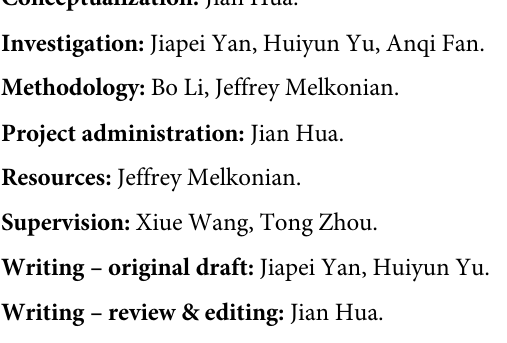
DC 3000 infection. Total RNAs were isolated from enriched guard cell preps and whole rosette leaves of 5-week-old plants. The expression was normalized to the expression of a reference gene ACTIN2 and relative to their expression in Col-0 Values are arithmetic means ± S.E., dif- ferent letters indicate statistically significant differences between indicated plant lines ( p < 0.05, based on one-way ANOVA followed by Student’s t test). S7 Fig. Stomatal responses to avirulent strains of Pst DC3000. Stomatal apertures in response to buffer alone (mock) and Pst DC3000 strains (with or without indicated effectors) in the Col-0 ( a, left panel of b ) and rpm1 ( right panel of b ). Results are from one set of experi- ment, error bars indicate SDs (n = 30 stomata). Asterisks indicate statistically significant differ- ences in stomata aperture between Pst DC3000 and avirulent Pst DC3000 treatment ( � , p < 0.001, student’s t test). S1 Table. List of oligos used in this study. S2 Table. Summary of stomatal and apoplastic defense phenotypes of mutants in this